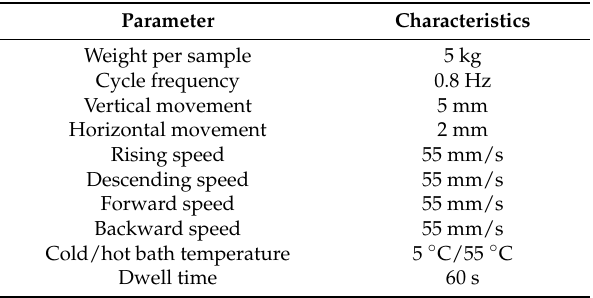
Table 2. Parameters of the chewing